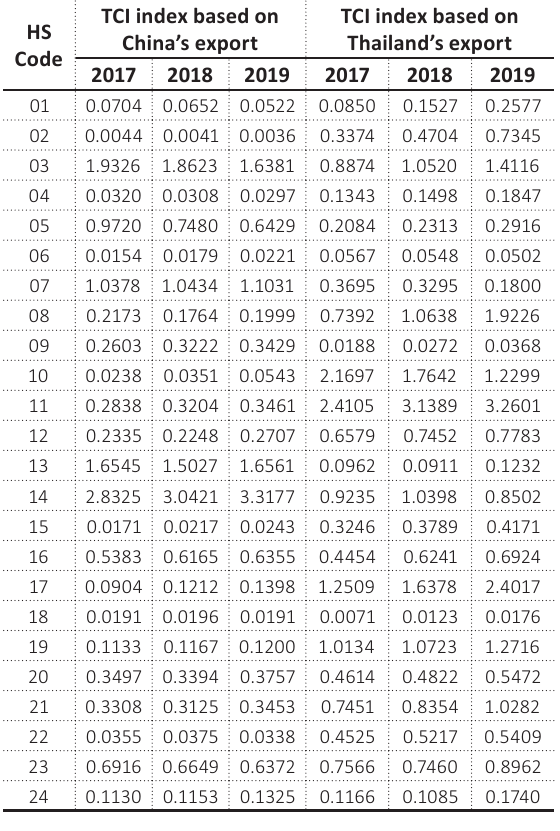
Table 3. TCI index based on China’s export and Thailand’s import, and Thailand’s export and China’s import (2017, 2018, and